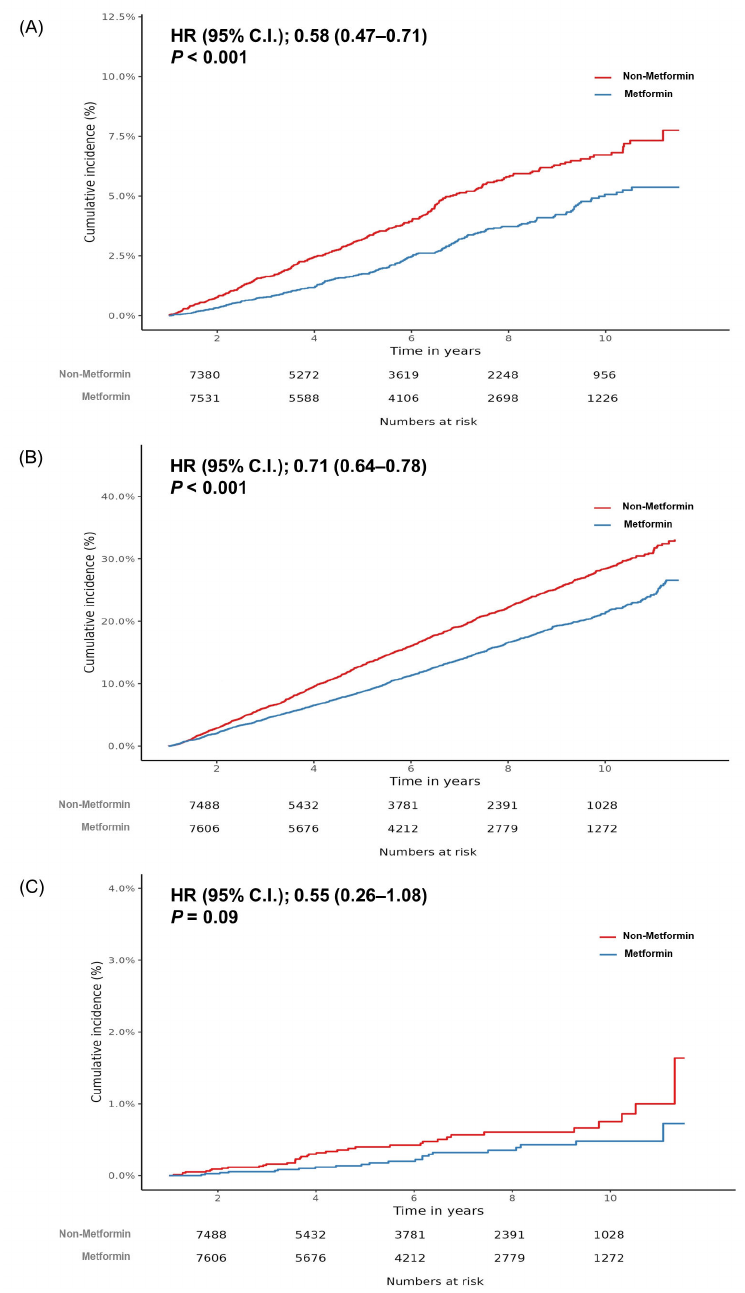
Figure 2. Kaplan–Meier curve for the cumulative incidence of colorectal cancer ( A ), all-cause mortality ( B ), and colorectal cancer-related mortality ( C ) between metformin users and non-users. HR, hazard ratio; CI, confidence